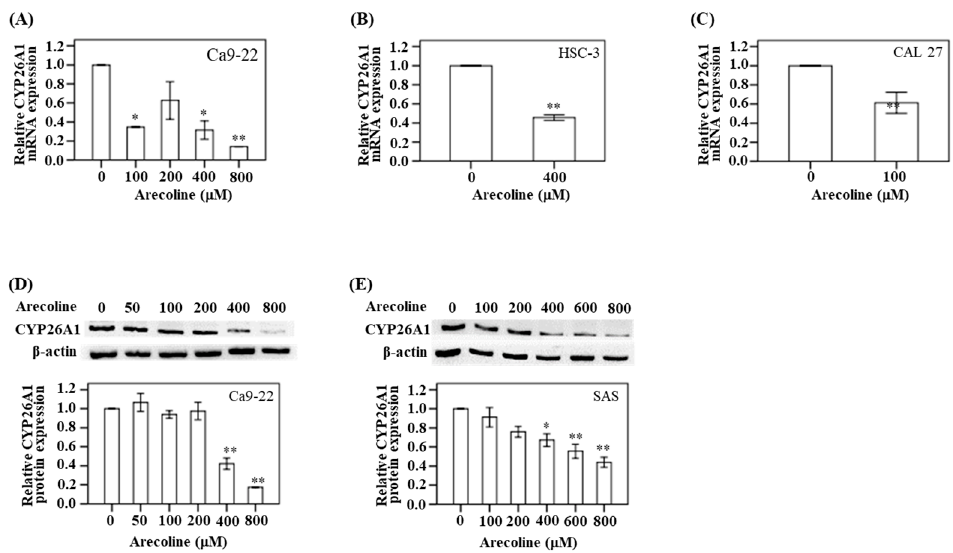
Figure 3. CYP26A1 expression in oral cancer cells treated with different concentrations of arecoline. ( A ) The relative mRNA expressions were detected in Ca9-22 treated with arecoline (0, 100, 200, 400, and 800 µ M). ( B ) HSC-3 treated with arecoline (0 and 400 µ M). ( C ) CAL 27 treated with arecoline (0 and 100 μ M). ( D ) The relative protein expressions were detected in Ca9-22 treated with arecoline (0, 50, 100, 200, 400, and 800 µ M). ( E ) The relative protein expressions were detected in SAS treated with arecoline (0, 100, 200, 400, 600, and 800 µ M). The average fold change (mean ± SD) of the CYP26A1 gene was measured in triplicate. * p < 0.05 and ** p < 0.01 compared with untreated control.